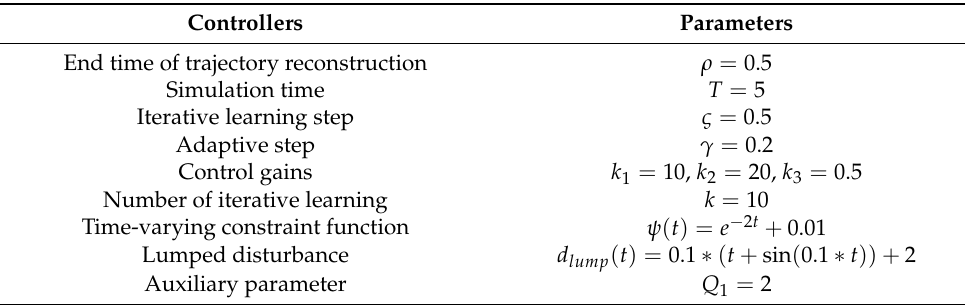
Table 2. Control